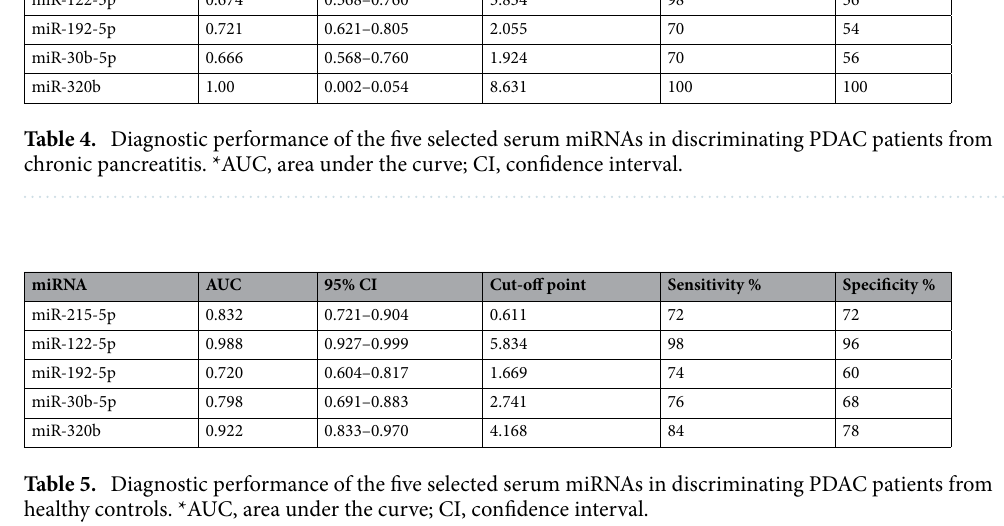
Table 5. Diagnostic performance of the five selected serum miRNAs in discriminating PDAC patients from healthy controls. *AUC, area under the curve; CI, confidence interval.